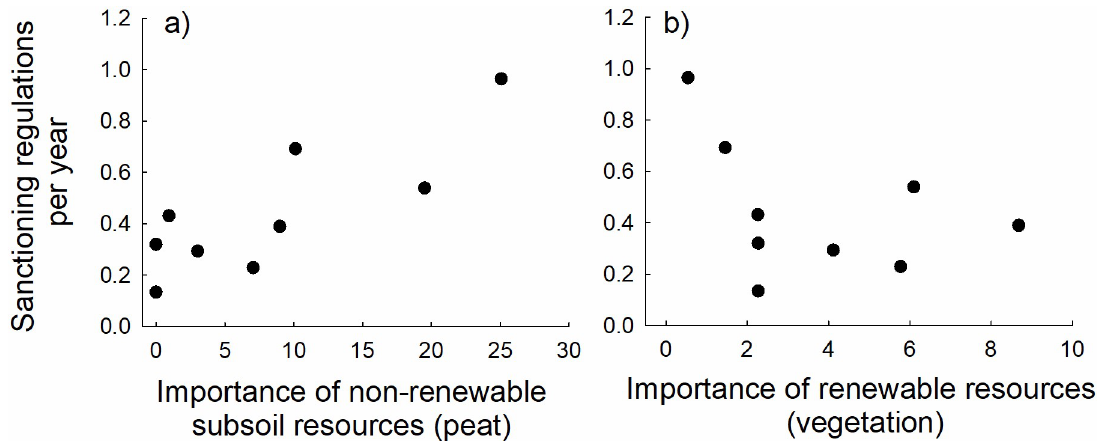
Fig 3. Relationship across Dutch commons between the annual frequencies of enforcement mechanisms in the form of sanctioning related regulations and the relative amount of sanctioning regulations directed to a) finite subsoil (primarily peat) resources r = 0.82, N = 9, P = 0.0066 and b) renewable (vegetation) resources r = -0.39, N = 9, P = 0.30.